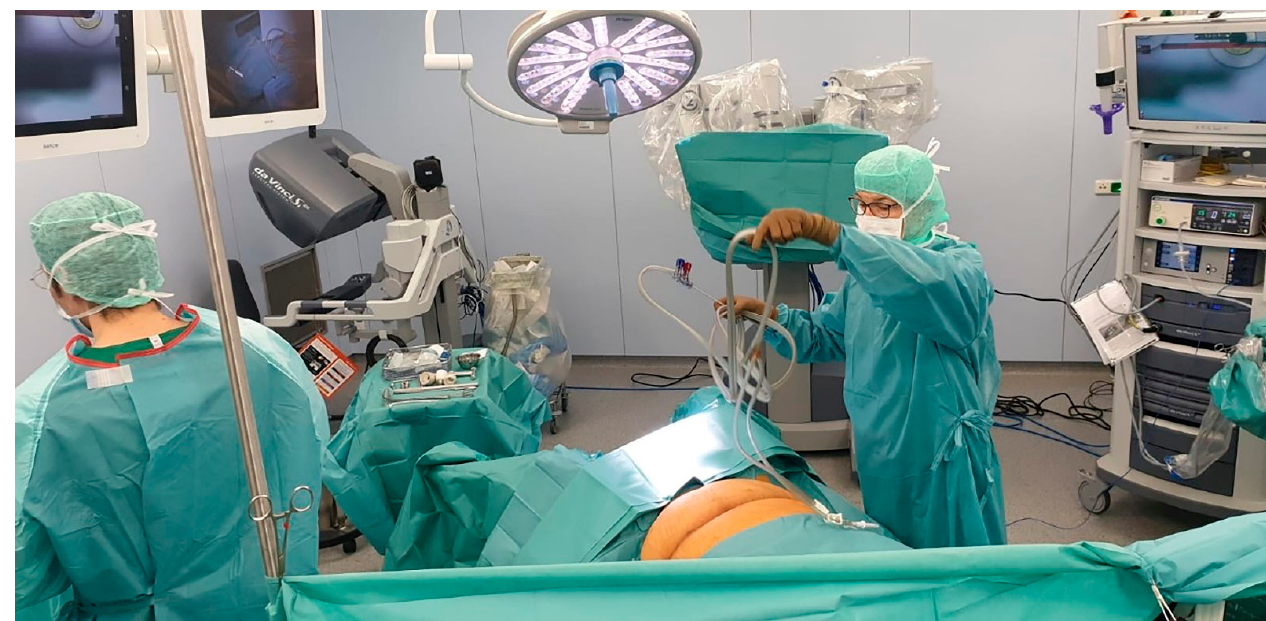
Figure 2. Operating room with robotic tower, Da Vinci console, patient in Trendelenburg position. The two robotic arms are attached to the lateral right and left trocars. Occasionally, a third arm is used. The robotic instruments (Figure 3) are then introduced.